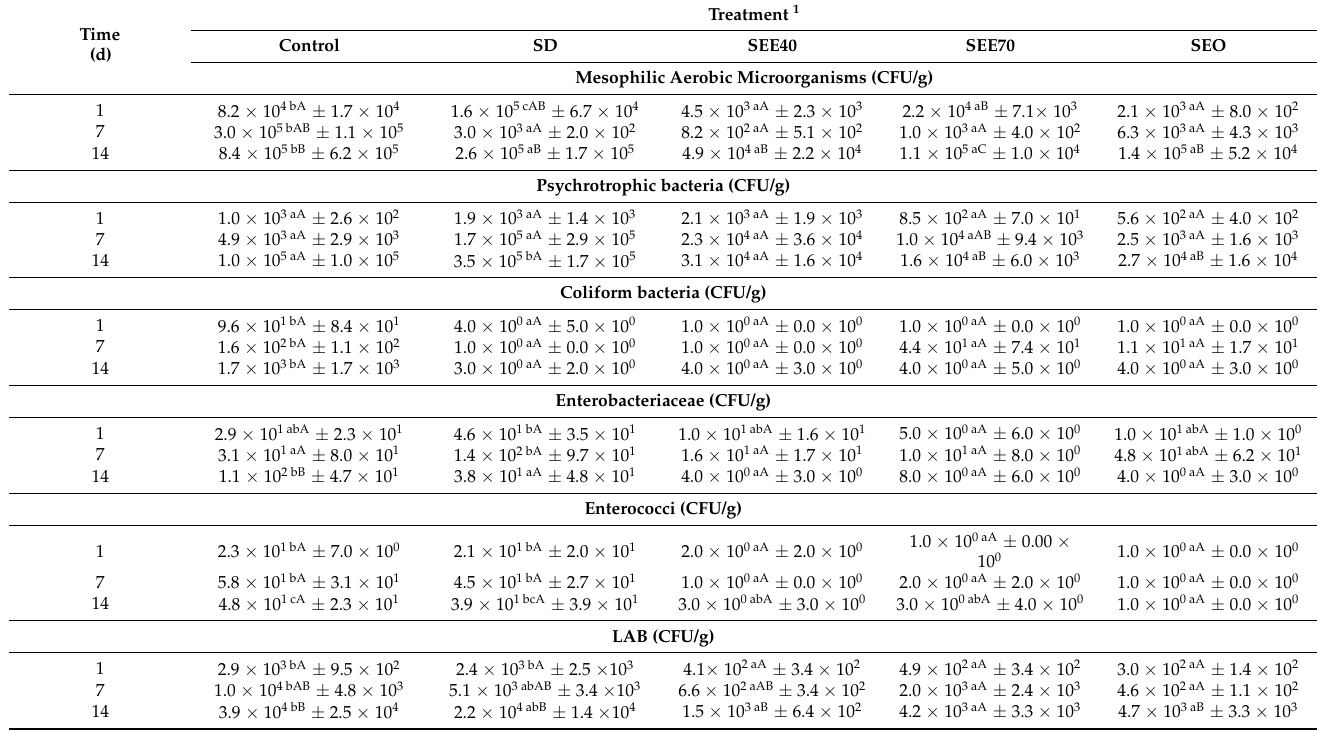
Table 2. Changes in the microbiological quality * of chicken meatballs containing MSM from chickens during refrigerated storage (mean value ± standard deviation; n =